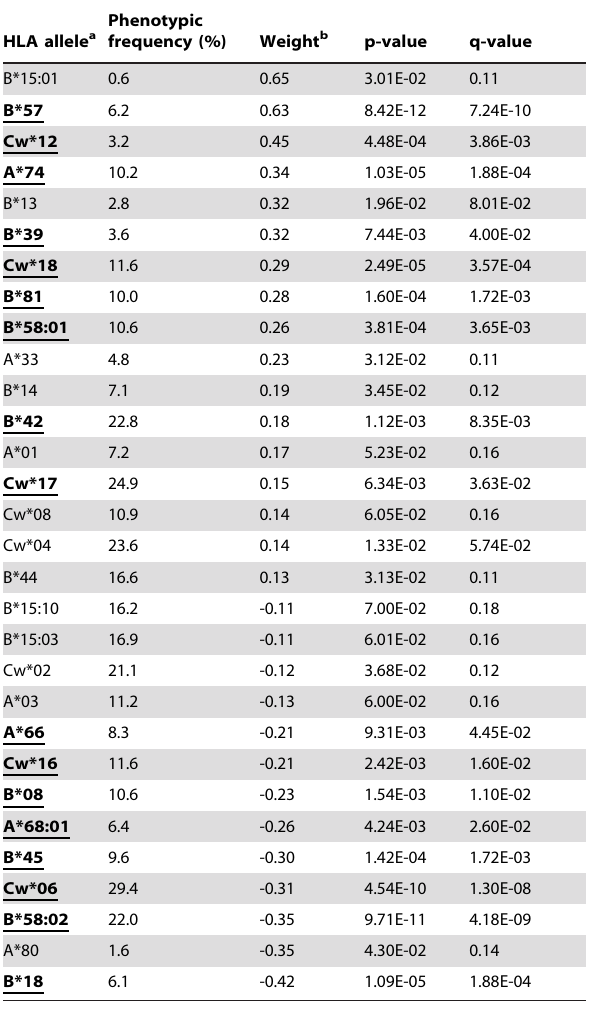
Table 3. Univariate analysis of the impact of HLA Class I alleles on CD4 + T cell count in 2031 HIV-1 C-clade infected Southern African subjects (q ,